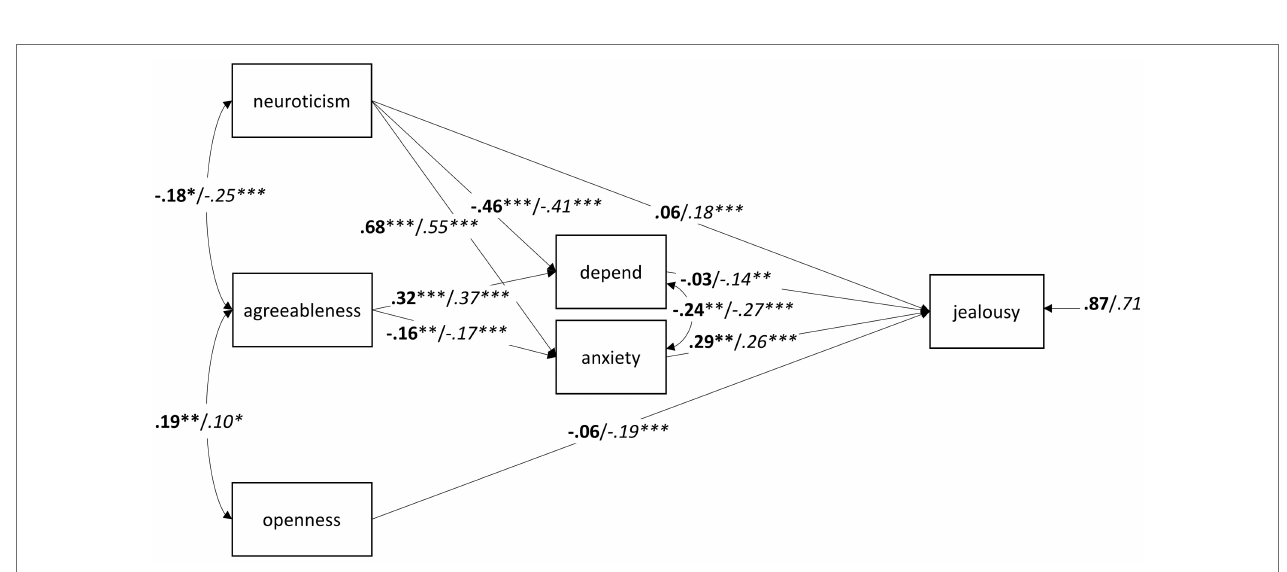
FIGURE 3 | Path analysis with standardized estimates for the relationships between the adult attachment subscales depend and anxiety , neuroticism, agreeableness, openness, and jealousy in 203 singles (bold) and 633 individuals in a committed relationship (italics). * p < 0.05; ** p < 0.01; *** p <